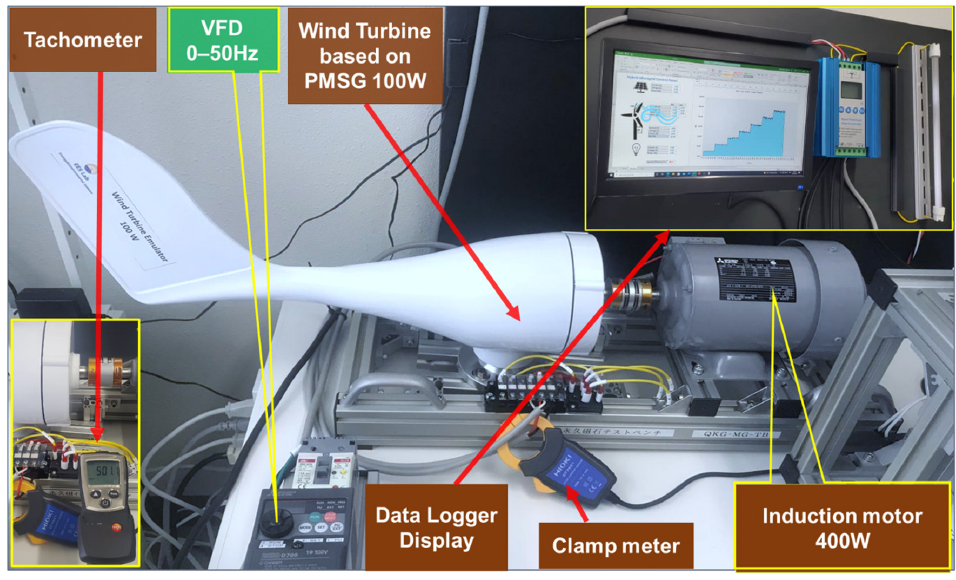
Figure 5. Wind turbine experimental setup in this study.